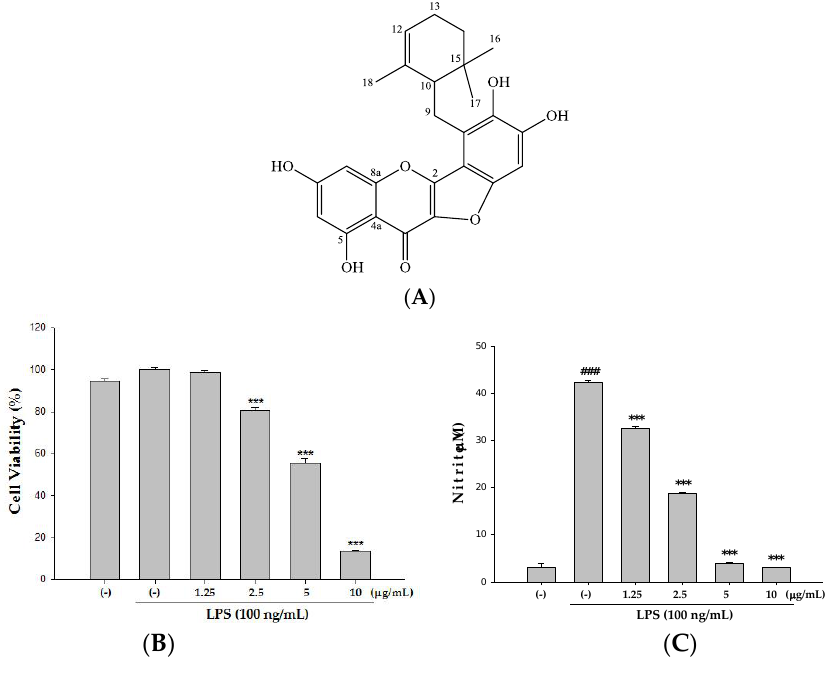
Figure 2. ( A ) Chemical structures of Ugonin M from Helminthostachys zeylanica ; ( B ) cytotoxicity; and ( C ) effect of NO production of Ugonin M in lipopolysaccharides (LPS)-stimulated RAW264.7 cells. Cells were pretreated with different concentrations of Ugonin M, 10, 5, 2.5, 1.25, or 0 μg/mL (0 referred to as (−)), for 1 h prior to the addition of 100 ng/mL LPS for 24 h. Cell viability assay was performed using MTT assay. Nitrite concentration in the medium was determined using Griess reagent. The data were presented as mean ± SD for the three different experiments performed in triplicate. ### p < 0.001 was compared with a sample of the control group (one-way ANOVA followed by Scheffe’s multiple range tests). *** p < 0.001 was compared with the LPS-only group.